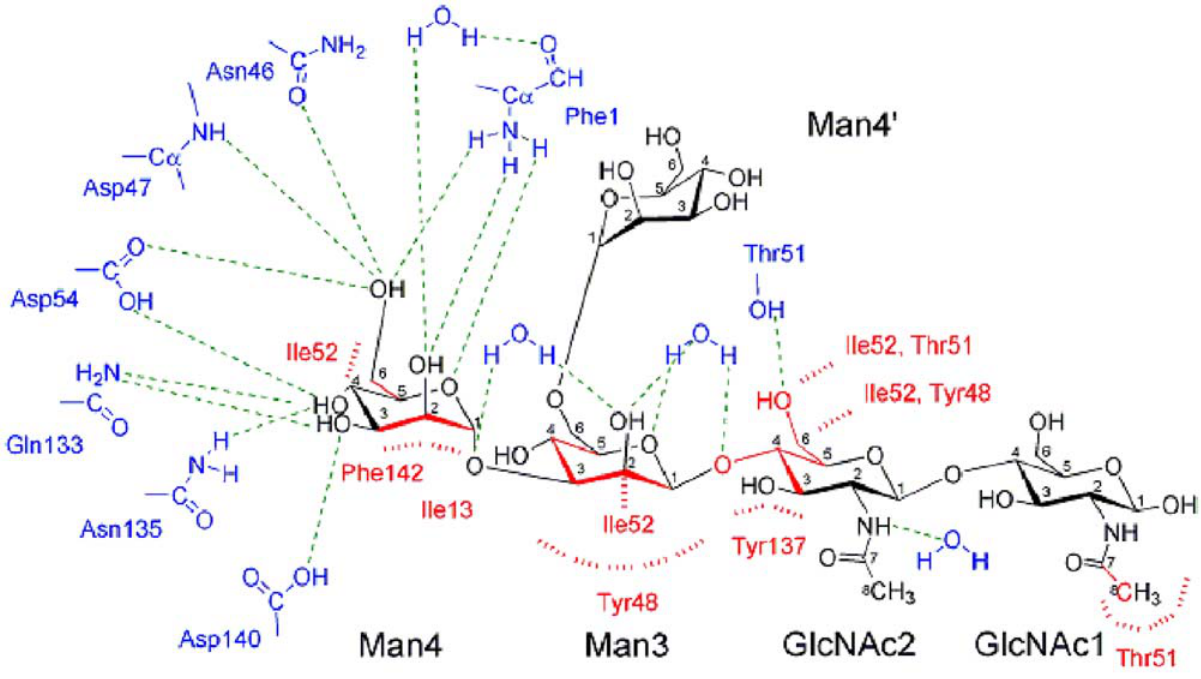
Figure 4. Scheme of the interactions in the extended FimH receptor-binding pocket. A network of hydrogen bonds (green dashed lines) surrounds Man4. Further along oligomannose-3, only water molecules make hydrogen bonds along one side of oligomannose-3 except for the Thr51 side chain. The residues of the tyrosine gate, Tyr48, Ile52 and Tyr137, interact via aromatic stackings, hydrophobic and van der Waals contacts (all marked in red) mainly with Man3 and GlcNAc2.